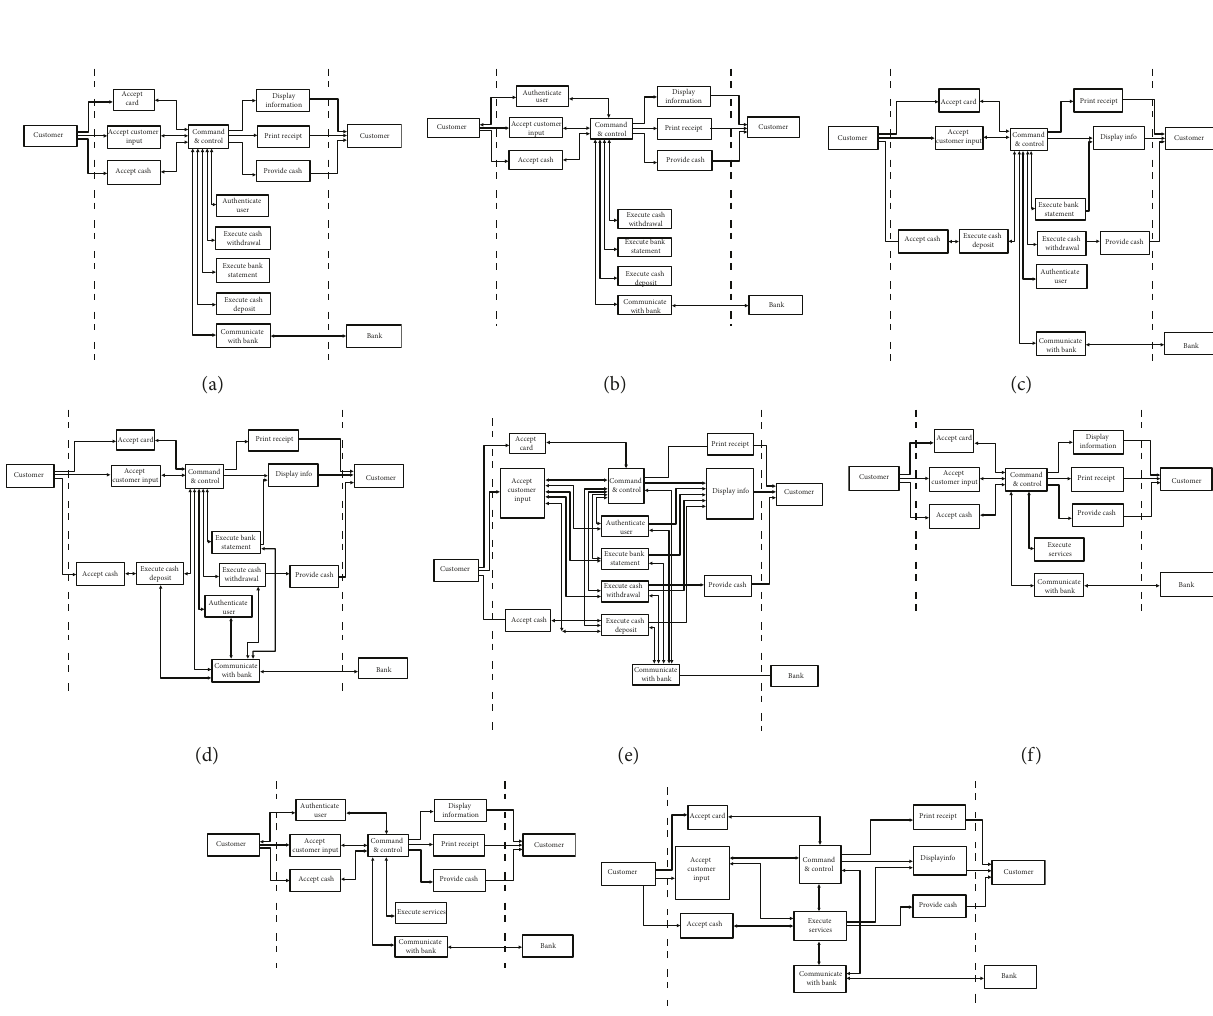
Figure 2: Alternative systems representations of an ATM used in the